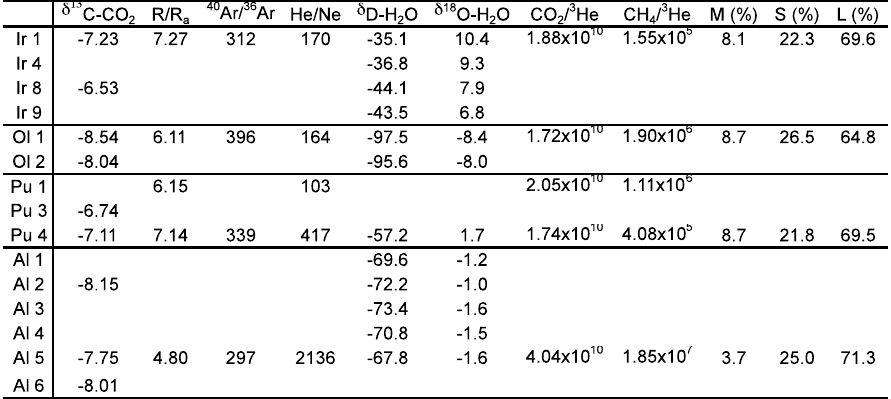
/ 3 He and CH / 3 He ratios of fumaroles 2 4